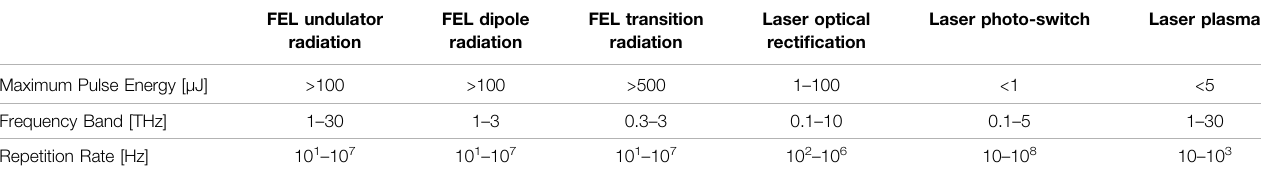
TABLE 2 | Beam characteristics comparison for various sources (modi fi ed from [42]).